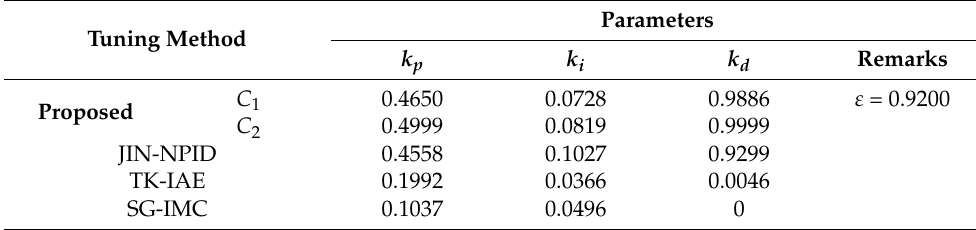
Table 10. PID controller tuning for process 4.